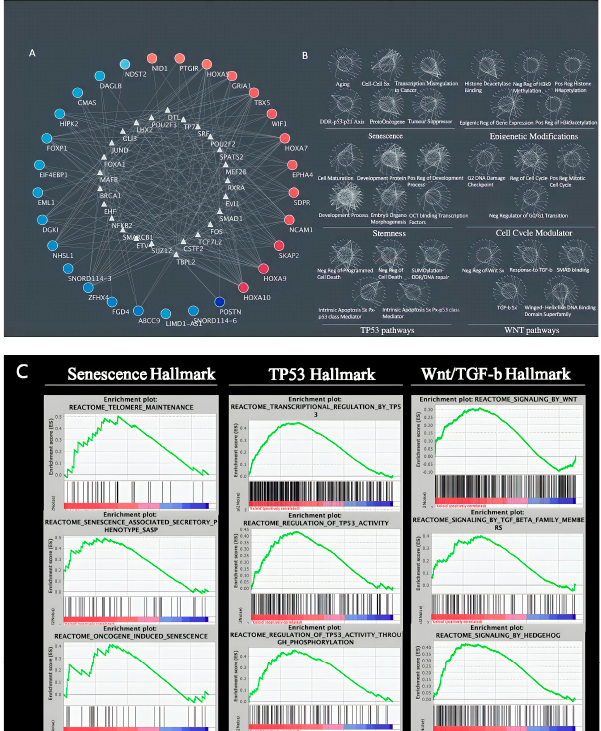
Figure 5. Target hallmarks are co-regulated in keloid etiology. ( A ) DEG of keloids versus control is displayed in outer circle and their enriched transcription factors in the inner circle; ( B ) The same DEG-TF interactions are present in these regulated target hallmark; ( C ) GSEA confirmation of target hallmark enrichment. 4. Discussion According to the RNA-seq data in the GEO database, we obtained DEG comparing keloid versus control fibroblasts and revealed several key genes, such as HOXA10 and HOXA9, that enriched during the genesis of keloid. TGF- β signaling, Wnt- β -catenin sig- naling, p53 pathway, hedgehog signaling, and several endogenous stress response reac- tions are the prominently enriched hallmarks of gene ontology (GO). Endogenous stress is emphasized by hallmark enrichments such as inflammatory re- sponse, ROS, metabolism reprogramming, hypoxia, UV response, and oxidative phos- phorylation hallmarks that ought to activate the senescence program[46]. To counteract these enrichments, hallmarks such as unfolded protein response, autophagy, DNA repair, protein secretion signaling, and apoptosis are activated.